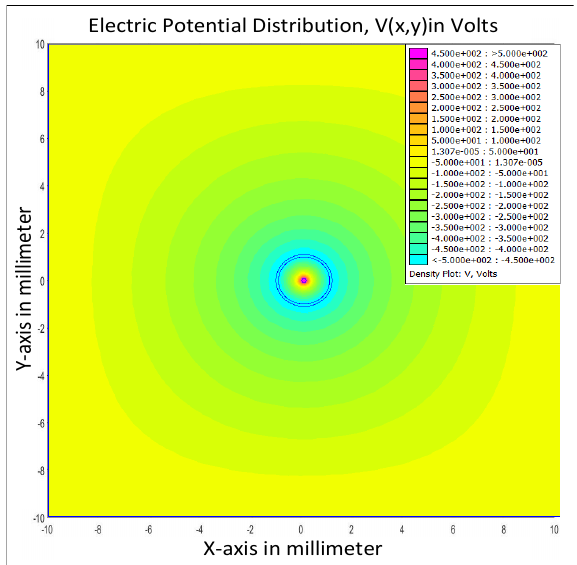
Figure 12. The electric potential distribution of the proposed device when the diameter of the thin wire is doubled.